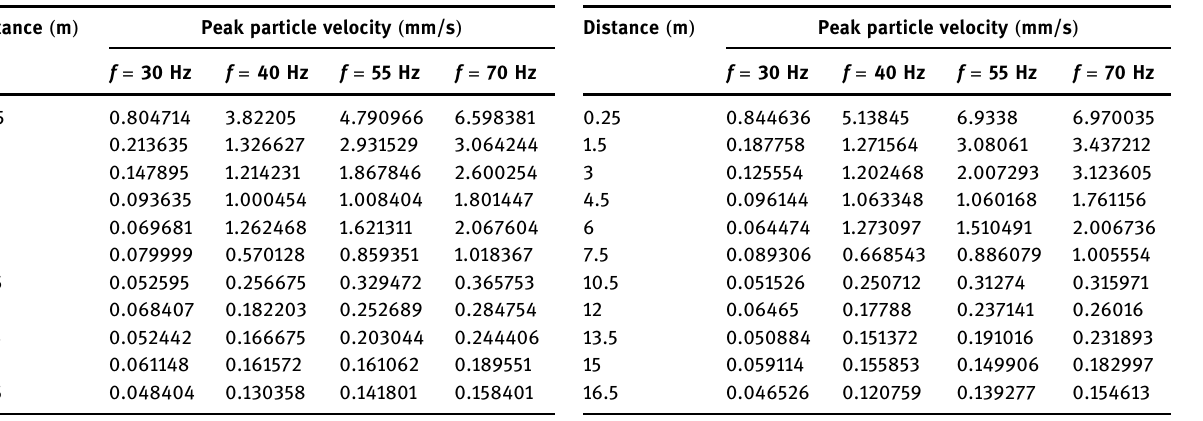
Table 12: The measured peak particle velocities at di ff erent loca - tions for various frequencies ( passive in - fi lled with 30% rubber trench barrier